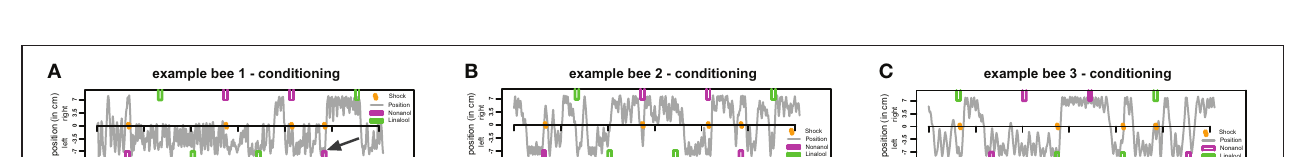
FIGURE A1 | Acquisition curves in PER. (A) Observed PER rates during the 8 stimuli of the conditioning phase, 4 of which are responses to the CS + (connected by solid line) and 4 to the CS − (dotted line) which were presented to the bees in pseudorandom order (ABBABAAB or BAABABBA). Difference between the responses to CS + and CS − was significant from the second trial ( p < 0 . 001, χ 2 = 322 . 88, df = 8, repeated measurement logistic regression). N = 164. Error bars show 95% confidence intervals. (B) Bees were conditioned to linalool and